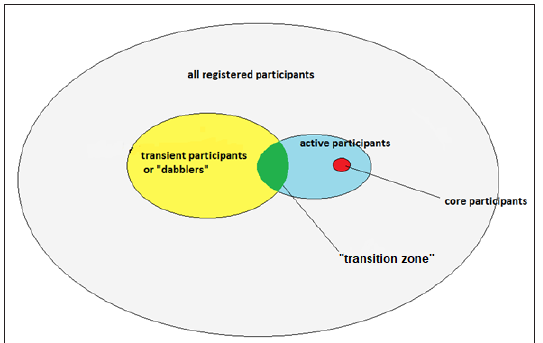
Figure 5: Patterns of participation in online citizen science